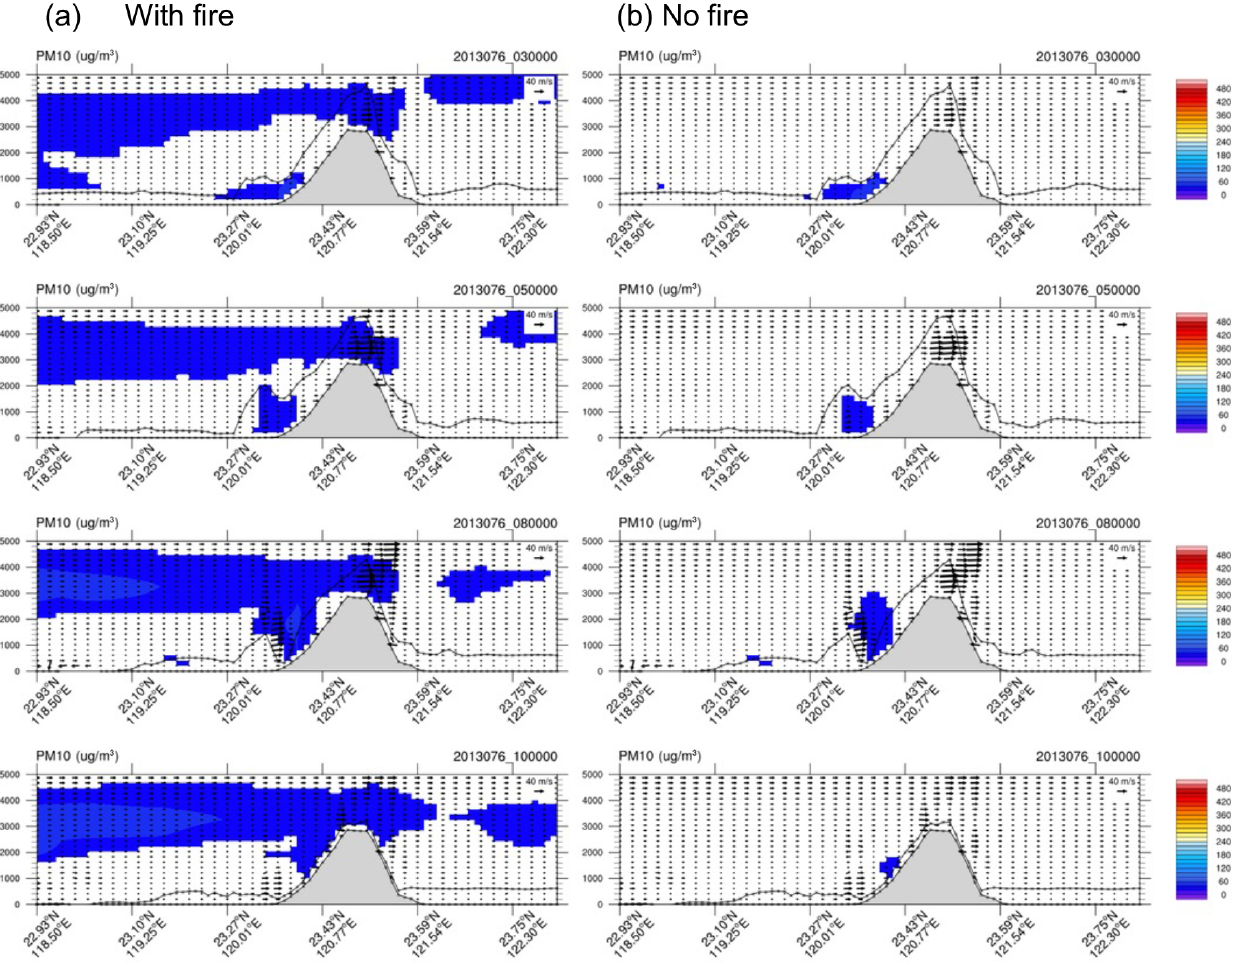
Figure 12. Similar to Fig. 10 but on 22 March 2013 at 11:00, 13:00, 16:00 and 18:00LST (a) with fire (b) with no